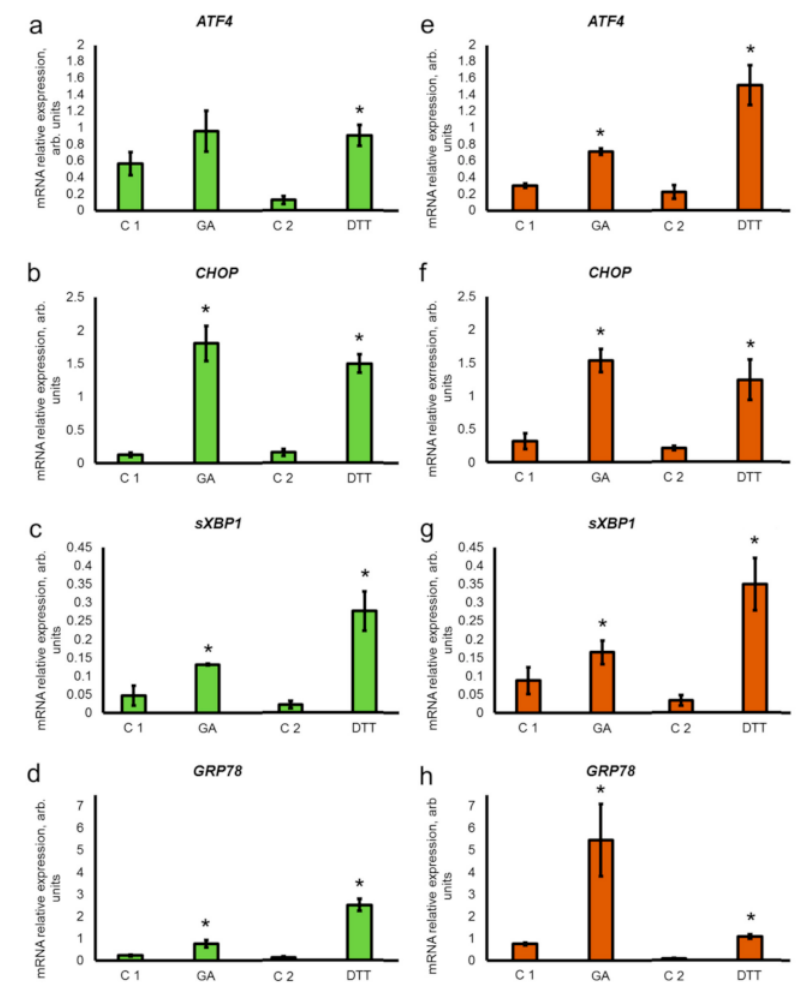
Figure 1. Levels of mRNA expression of the ER stress genes ATF4 , CHOP , sXBP1 , and GRP78 in keratinocytes HaCaT ( a – d ) and carcinoma A431 cells ( e – h ) after 24 h of incubation with 2 mM of gibberellic acid (GA) and 2 mM dithiothreitol (DTT). C1—control for GA when ethanol as a